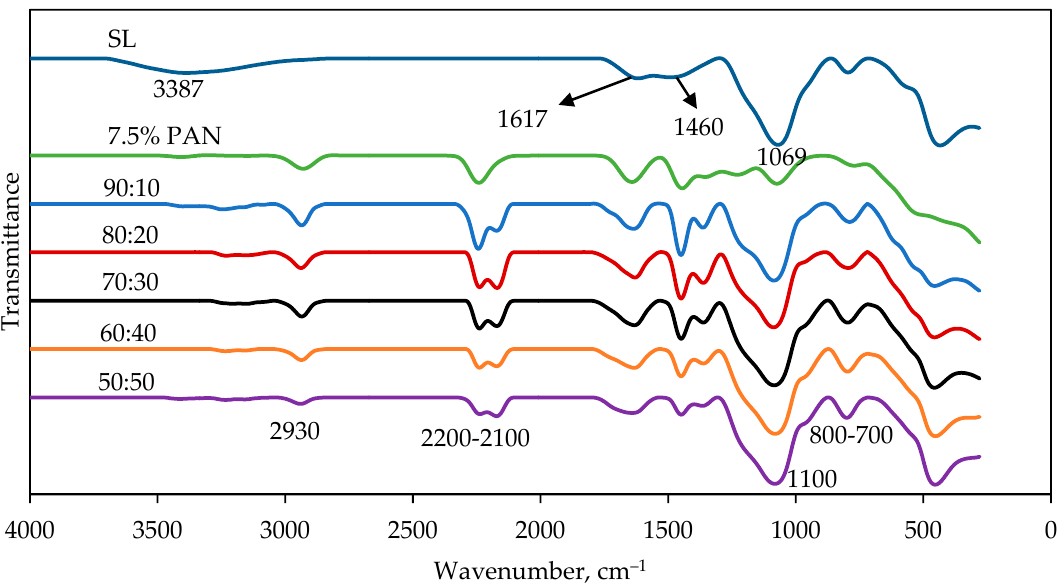
Figure 2. The comparison of spectra between SL, 7.5% PAN and PAN/SL nanofibers of different ratio of PAN:SL.